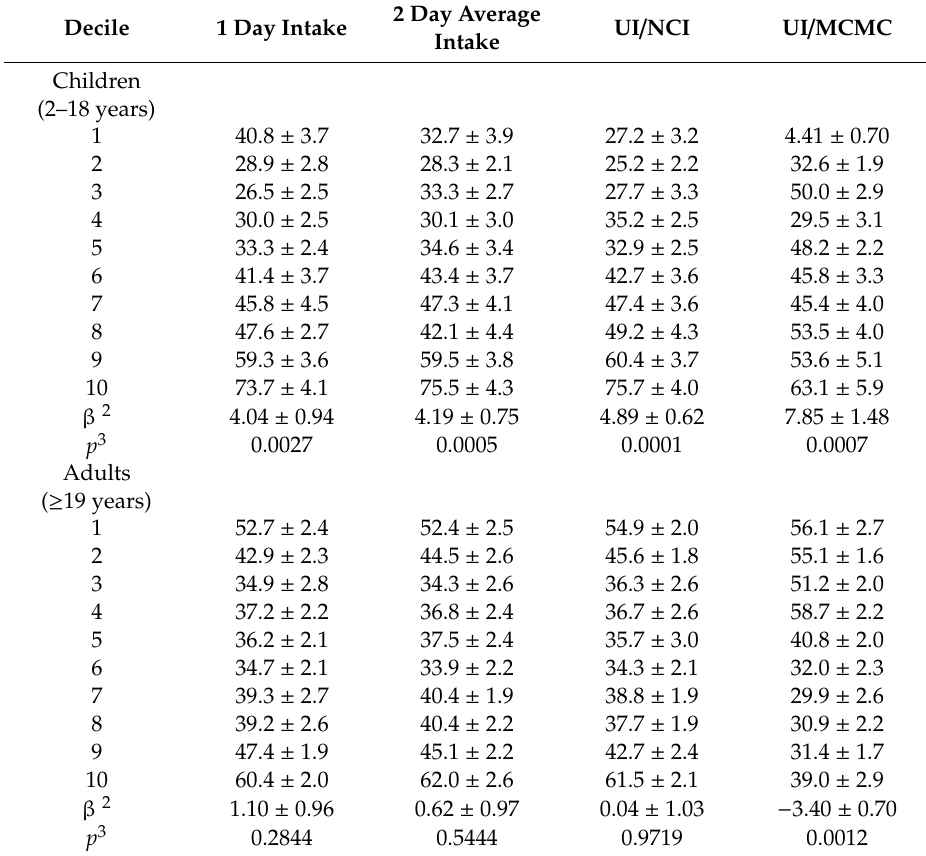
Table 2. Percentage of the population below the Estimated Average Requirement of calcium by deciles of added sugars intake by various methods, the NHANES 2011–2014.